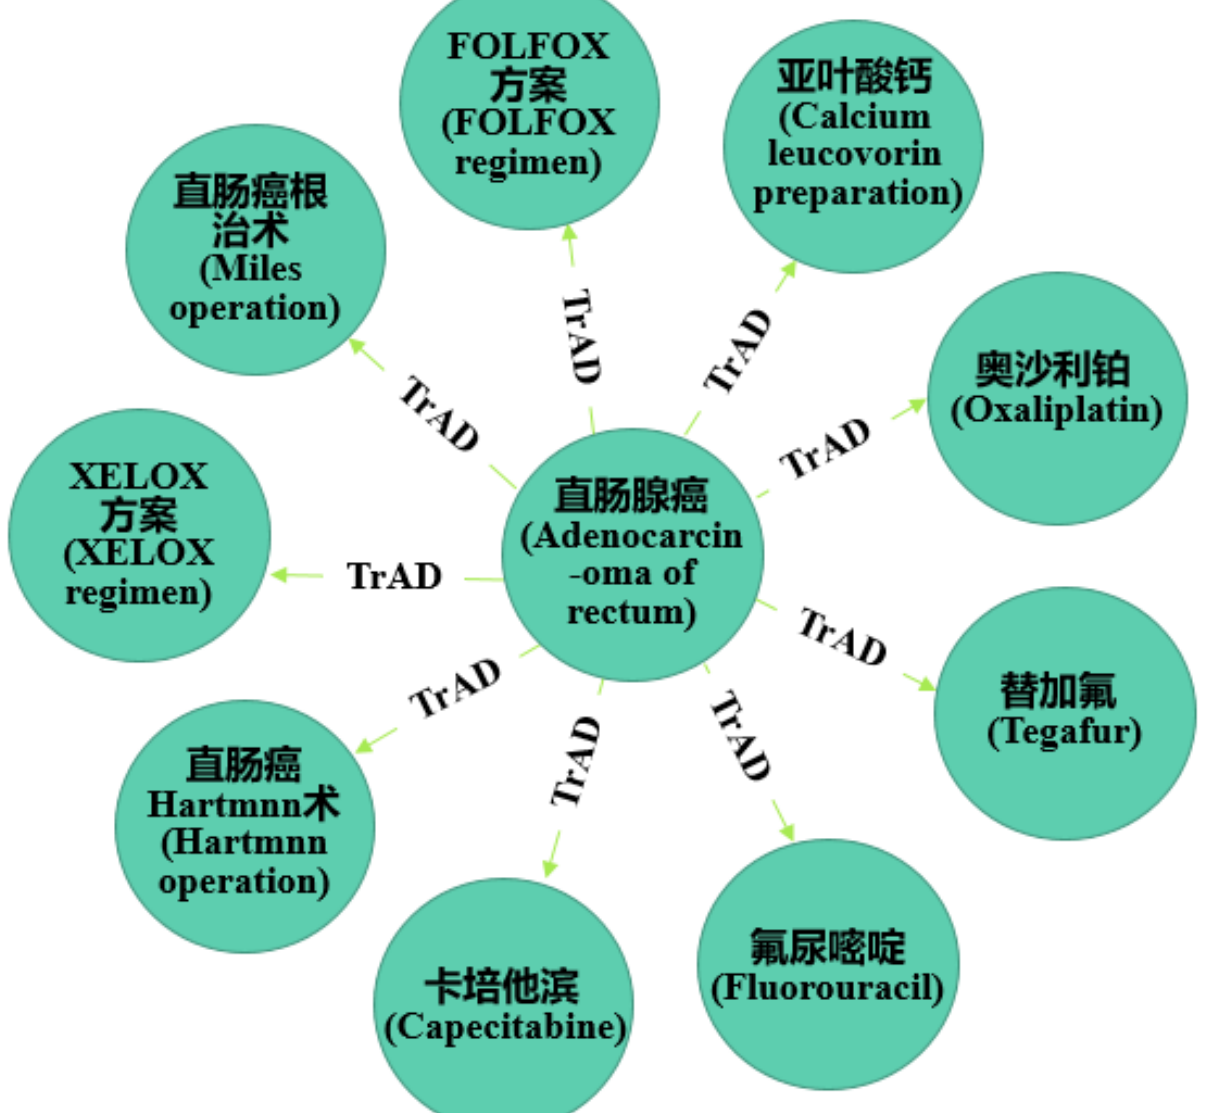
Figure 7. Treatment of rectal adenocarcinoma based on a search of Chinese electronic medical records using the search “MATCH (n:entities)-[r:TrAD]->(c) WHERE n.name=' 直肠腺癌 ' RETURN n,c LIMIT 2500” in the digestive system tumor knowledge graph. TrAD: treatment is administered for the